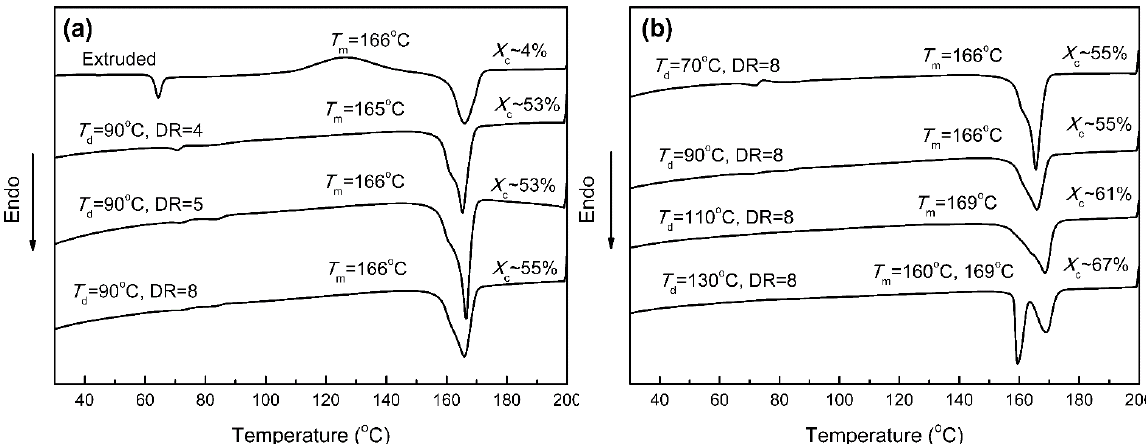
Figure 4. Differential scanning calorimetry (DSC) thermograms of ( a ) samples drawn at 90 °C with various draw ratios; and ( b ) samples drawn at different temperatures with a draw ratio of